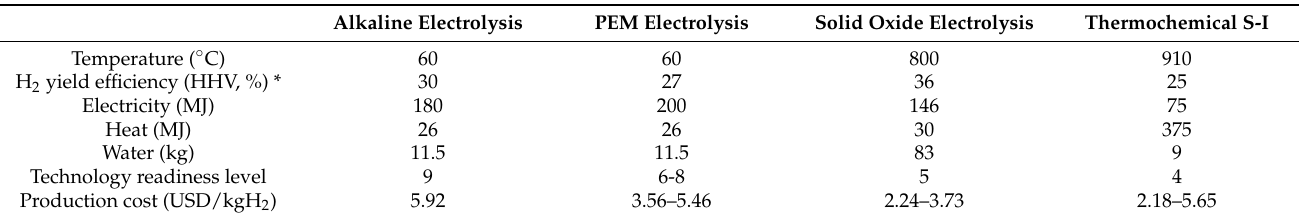
Table 1. Hydrogen production costs for nuclear hybrid energy systems [53]. Reprinted with permis- sion from